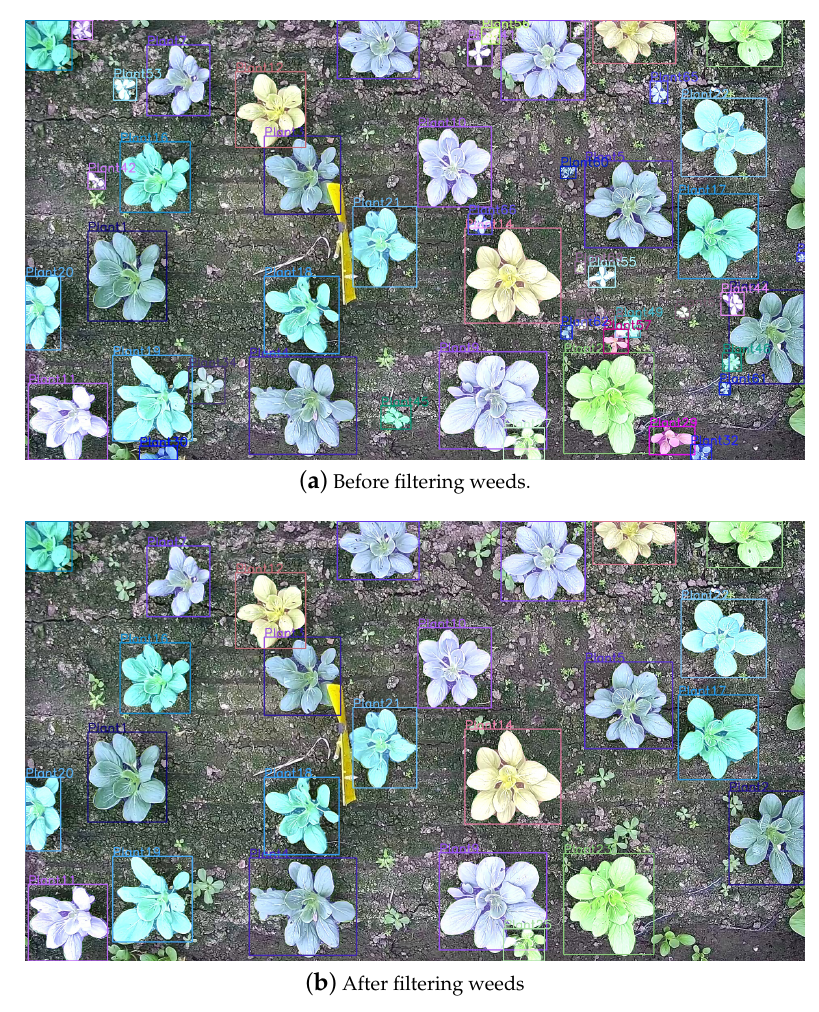
Figure 5. Comparison of weeds before and after filtering. As shown in Sub-figure ( a ), some objects are misidentified as leafy greens. After filtering weeds, objects that are mistakenly identified as leafy greens are removed, as shown in Sub-figure ( b